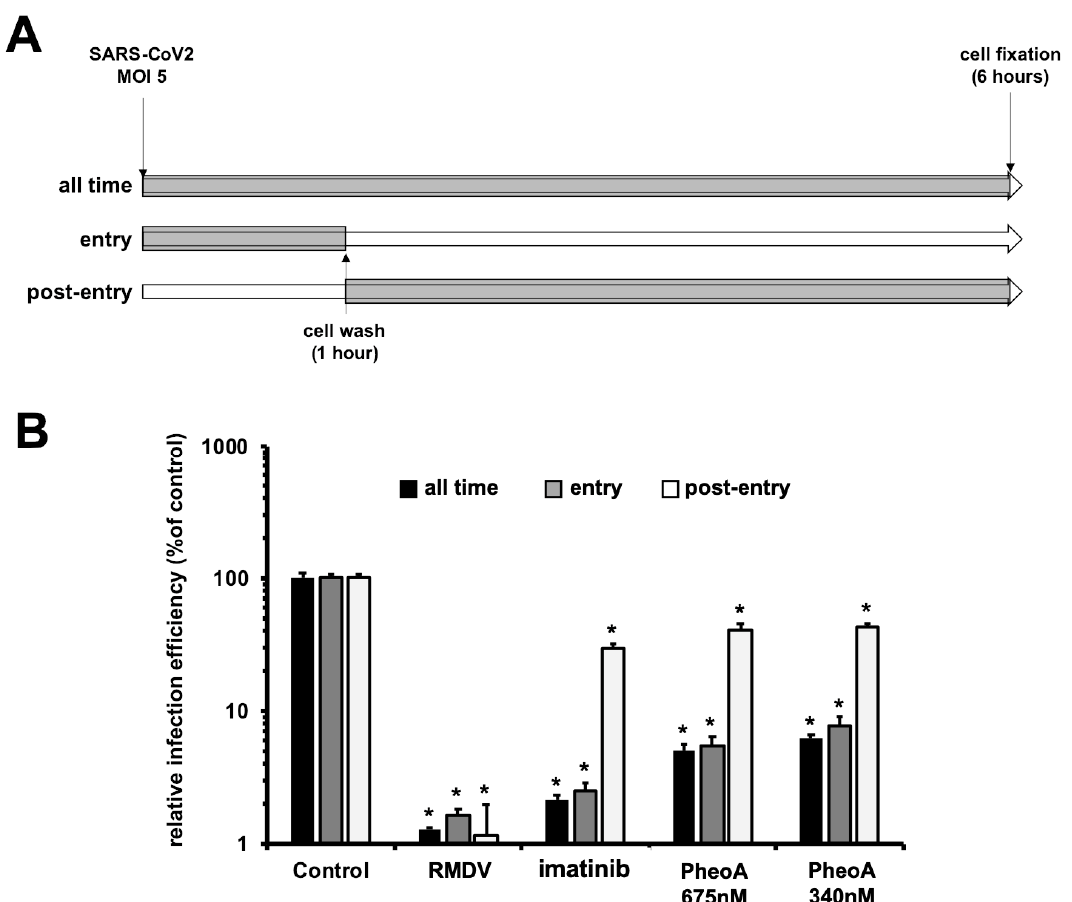
Figure 7. Time-of-addition experiments indicate that PheoA interferes with early aspects of SARS-CoV-2 infection. Vero E6 cells were inoculated at MOI = 5 in the presence (gray) or absence (white) of the indicated doses of PheoA, RMDV or imatinib as described in both the text and the scheme. Cells were incubated for 6 h in the presence (gray) or absence (white) before chemical fixation and processing for immunofluorescence microscopy. ( A ) Schematic diagram of the times where compound was present in the assay. ( B ) Infection efficiency is expressed as the percentage of that observed in vehicle DMSO-treated cells and is shown as average and standard deviation of three biological replicates ( n = 3). Statistical significance was estimated using one-way ANOVA and a Dunnet ´ s post hoc test (* p <